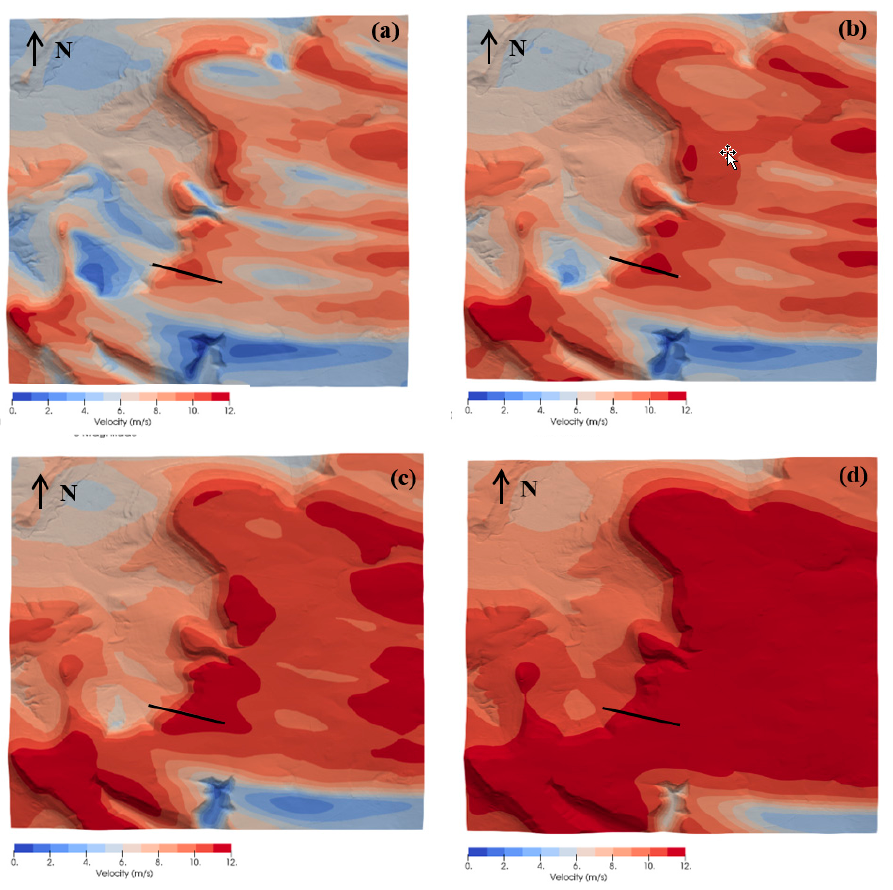
Figure 12. Velocity contour plots for leaf area index ( LAI = 2) and h = 20 m at 75 m ( a ), 125 m ( b ), 175 m ( c ) and 275 m ( d ) agl. on the 27 March 2015. The black lines correspond to the UAS flight path. For the evaluation of the results, the quantities will be plotted along a horizontal line, corresponding to the performed flight path and three vertical lines (Figure 13). Error bars, corresponding to one standard deviation, were inserted for the UAS